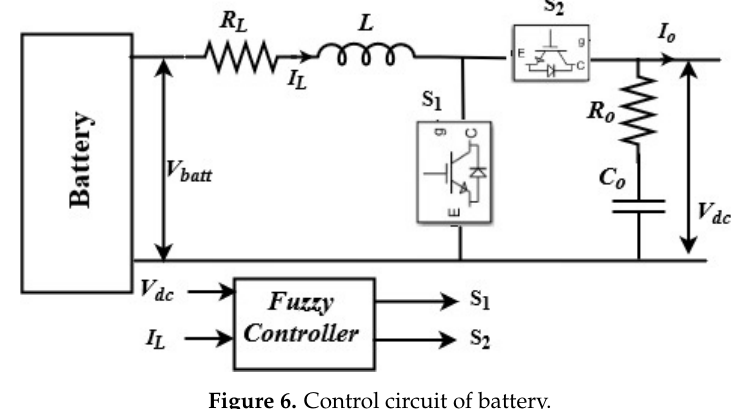
Figure 6. Control circuit of battery.